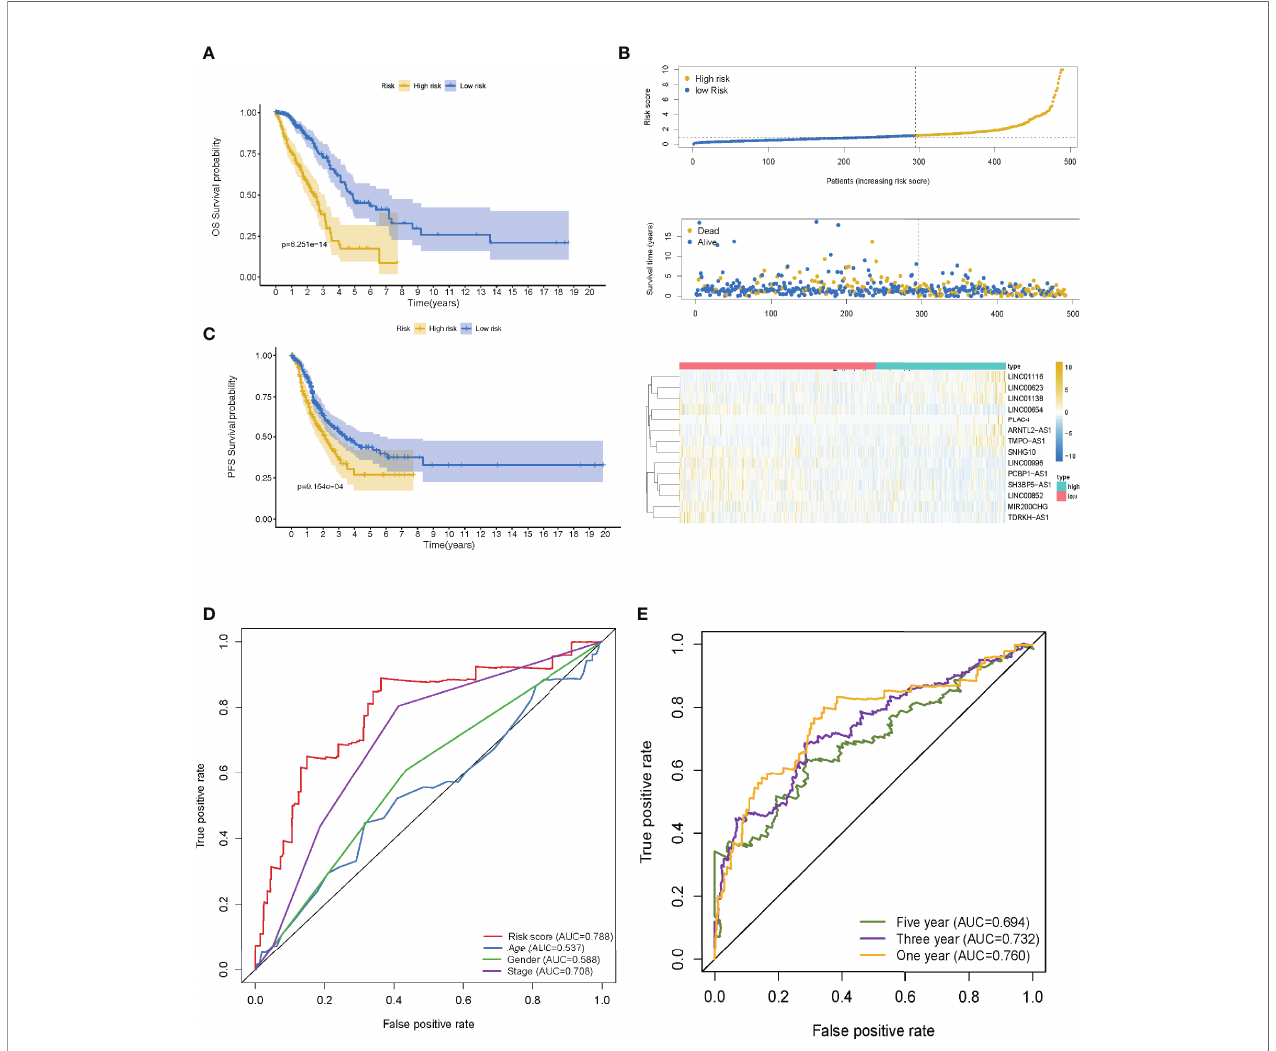
FIGURE 3 | The lactate metabolism-related (LMR)-lncRNA signature based on the training cohort. (A) Overall survival (OS) curves for LUAD in low- and high-risk groups in the training cohort using the Kaplan-Meier method. (B) Distribution of patients in TCGA cohort based on the median risk score and survival status for each case. (C) Progression-free survival (PFS) risk pro fi le for risk score-based patients. (D) The AUC values of the risk score and other clinical parameters. (E) 1-, 3-, and 5- year ROC curves to assess the prognostic accuracy of the LMR-lncRNA signature developed by the training